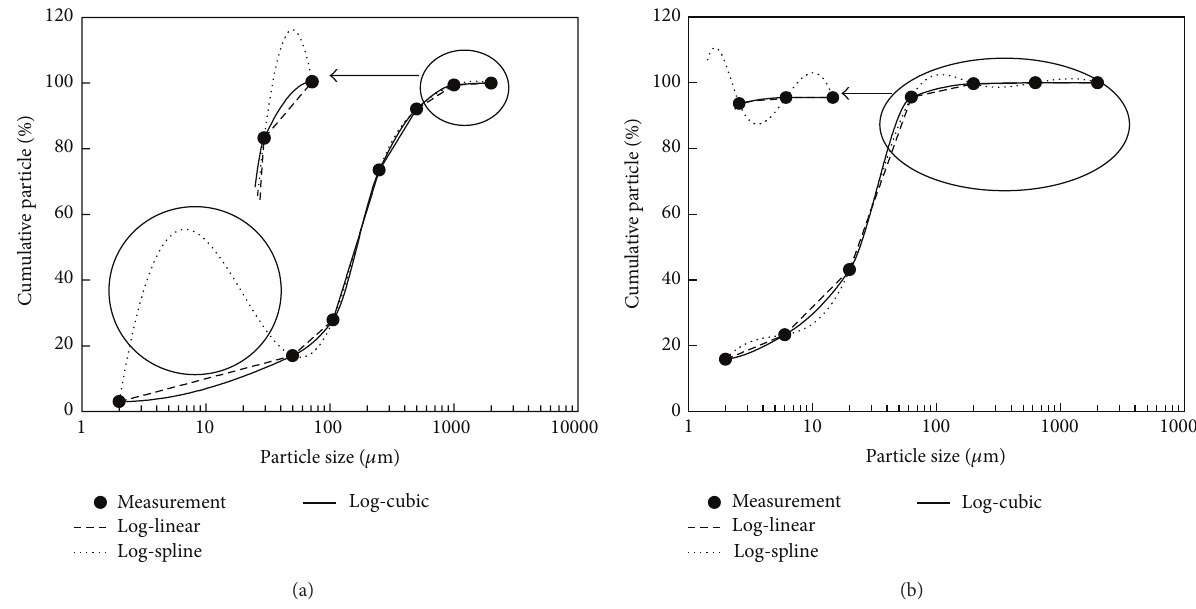
Figure 3: Examples of PSD curves generated from measured data (dots) using the log-linear (dashed lines), log-spline (dot lines), and log- cubic (solid lines) methods for soils nos. 1010 (a) and 1490 (b). Circles indicate particle size ranges in which PSD curves generated with the log-spline method are not